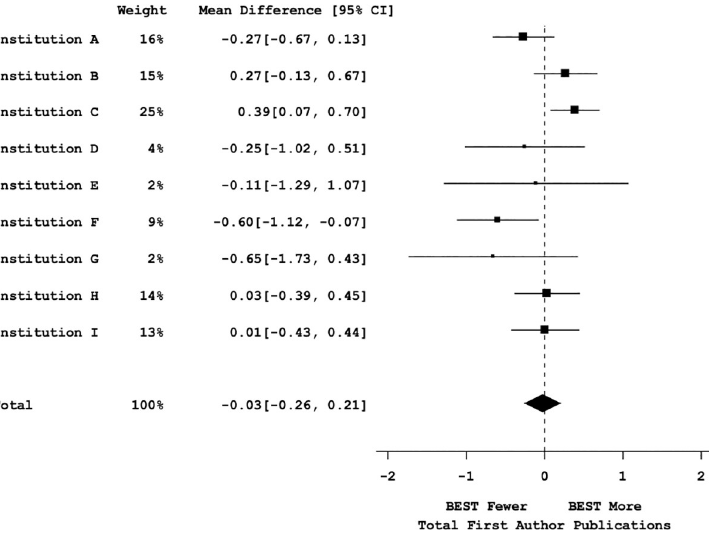
Fig 6. Graduate student productivity measured by first-author publications vs. bivariate participation. Mega- analysis forest plot displaying mean effect sizes (squares) and confidence intervals (brackets) for effect sizes of first- author publications vs. bivariate professional development participation (control vs. participants). Large squares denote greater impact on the summary effect based on sample size and effect size in each institutional sample. The vertical dotted line represents a null effect. The size and shape of the diamond at the bottom of the forest plot represent the effect size. Because the diamond overlaps the vertical line (null effect), this indicates that the effect of professional development participation on time to first-author publications is not significant. See Table L in S1 Text for statistical results. All data sets are available at https://osf.io/qy3pa/ (permanent DOI: 10.17605/OSF.IO/QY3PA; see also [33]). BEST, Broadening Experiences in Scientific